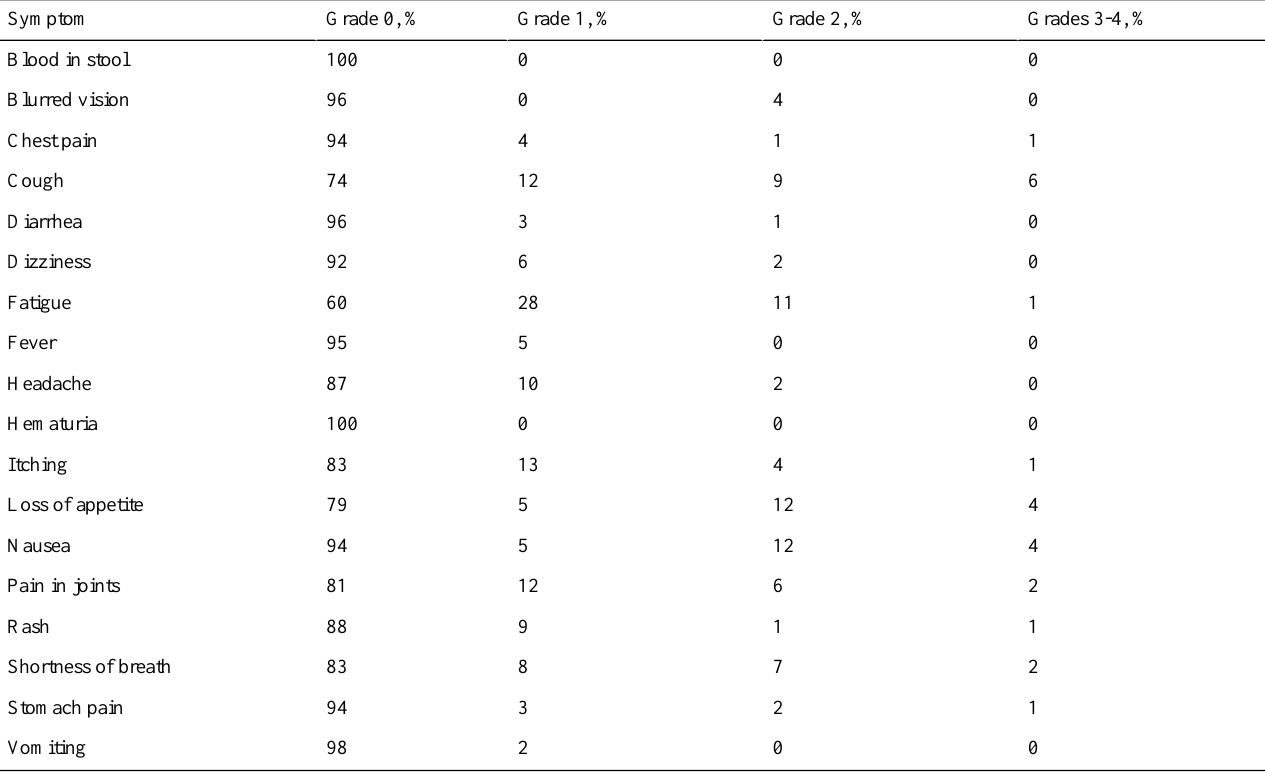
Table 3. Distribution of the severity of the reported symptoms according to all the answered symptom questionnaires (n=889) in weeks